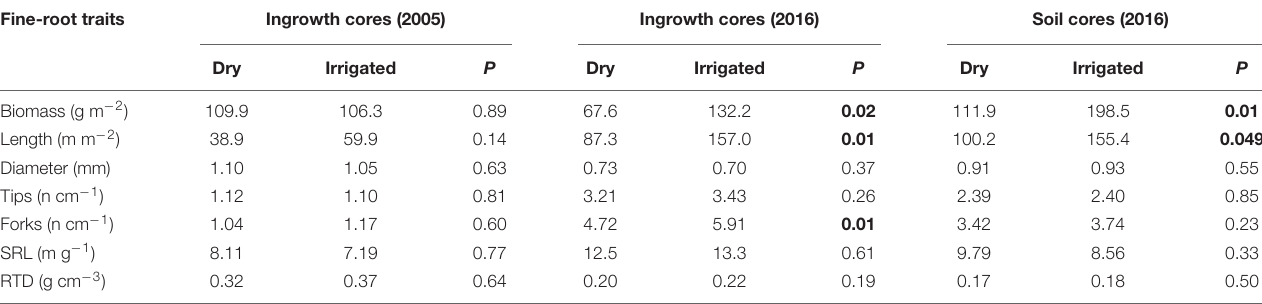
TABLE 2 | Comparison of fine-root traits of roots from ingrowth cores from 2005 and 2016 after 2 years of growth, and of roots from the soil-coring sample from 2016 of the Scots pine forest under dry and irrigated conditions.